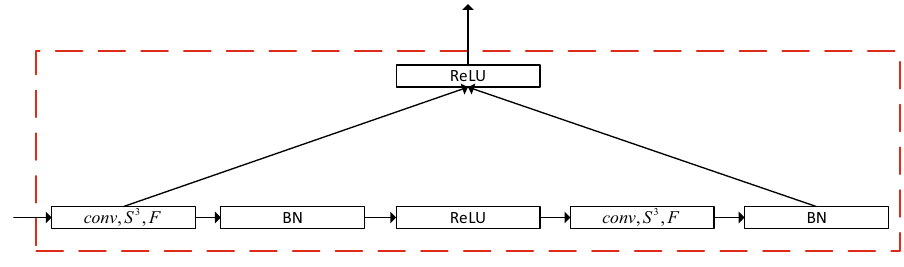
Fig. 1 Identification neural network unit (one